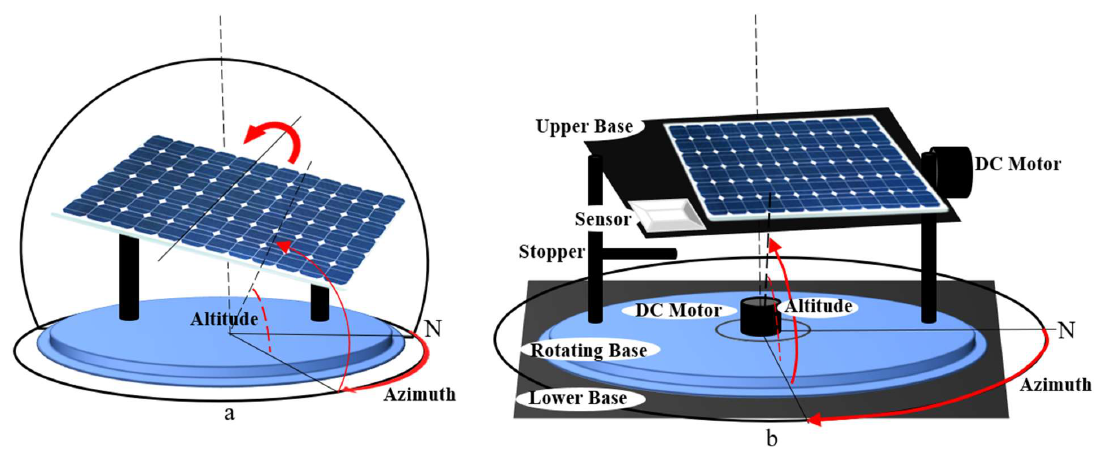
Figure 4. Various Dual-axis Solar Tracking Systems. ( a ) TTDAT; ( b ) AADAT. TTDAT, as shown in Figure 4a, is so termed because the panel array is positioned on the top of vertical poles. Typically, the east–west movement is caused by rotating the array around the top of the pole. The posts at each end of the primary axis of rotation of a tip- tilt dual-axis tracker can be reused between trackers to reduce installation expenses [30]. The primary axis of AADAT, also known as the azimuth axis, is parallel to the ground while the secondary axis, also known as the elevation axis, is normal to the primary axis [30]. A servo motor for the azimuth axis (horizontal) and a linear actuator for the elevation axis (vertical) are used in an AADAT to track the Sun [31]. AADAT systems can use a huge ring mounted on the ground with the array positioned on a series of rollers rather than rotating the array around the top of the pole as shown in Figure 4b. This enables AADAT to support much larger arrays; however, the system cannot be positioned closer together than the diameter of the ring, which may diminish system density, especially when inter-tracker shadowing is included [30]. The solar azimuth and altitude angles of a dual-axis solar tracking system can range from 61.1 ° to 299.1 ° and −10.1 ° to 10.7 ° , respec- tively [32].